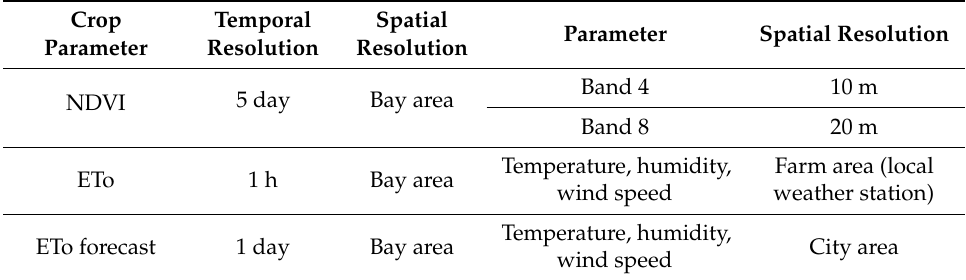
Table 3. Spatial and temporal heterogeneity in remote sensing and weather forecast